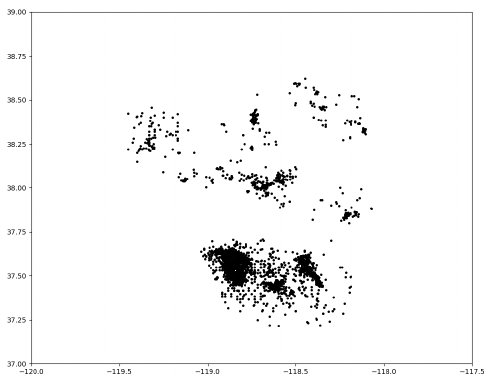
Figure 8. Initial array X for constructing the shell H ( A )